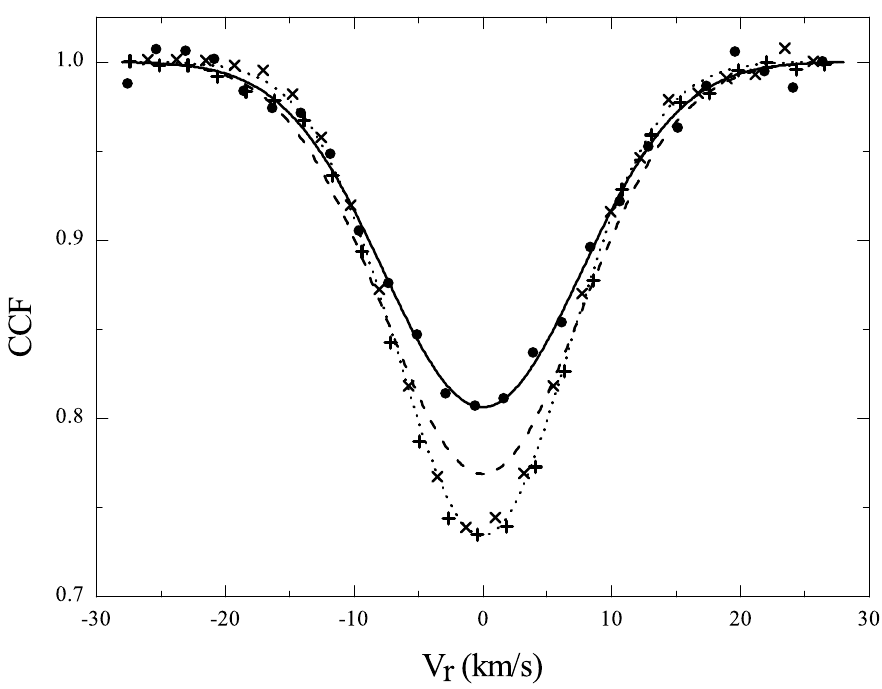
Fig. 5. Cross-correlation functions of BD+20 5152 (dots) and the standard stars G5 V, v sin i = 1.8 km/s (crosses), and K0 V, v sin i = 1.4 km/s (pluses). The solid and short-dashed lines are the Gaussians fitted to the observations. The dashed line is a fit to the corrected measurements of BD+20 5152 (see the